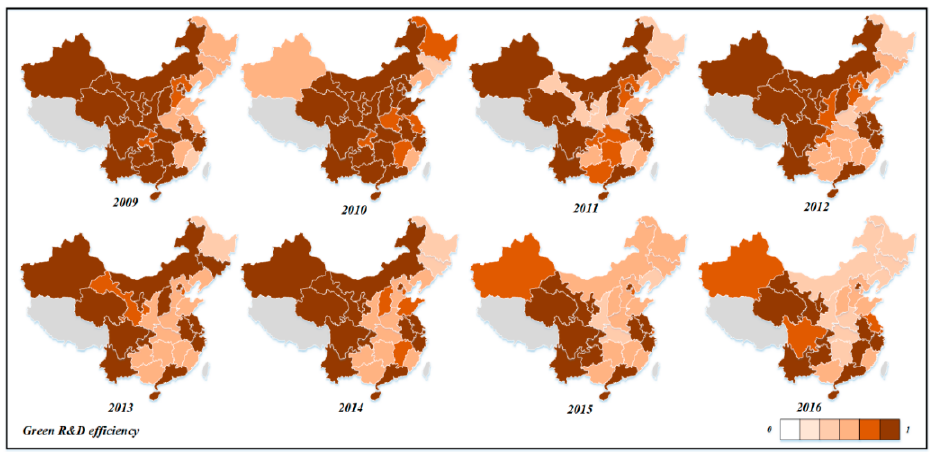
Figure 7. The evolution map of industrial enterprises’ green technology innovation in R&D efficiency in China (2009 – 2016).